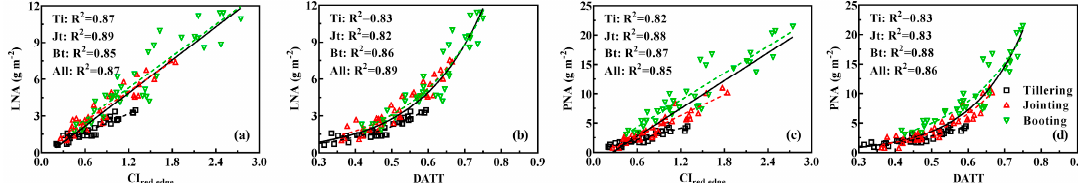
Figure 6. Leaf N accumulation (LNA, g m − 2 ) and plant N accumulation (PNA, g m − 2 ) plotted against red edge indices from MS images: CI red edge ( a , c ) and DATT ( b , d ). The black solid line is for pooled data and the dashed lines are for individual stages. All regressions are statistically significant ( p < 0.01).